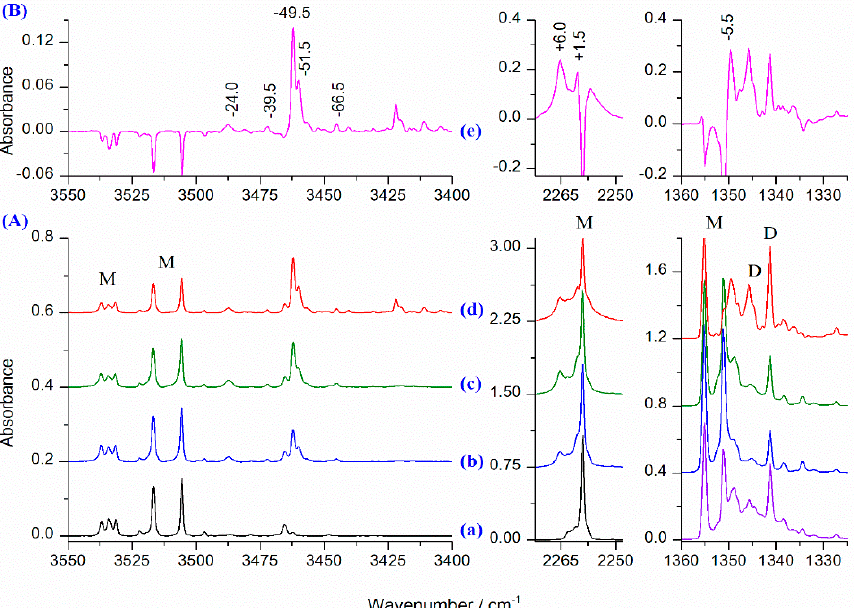
Figure 3. ( A ) The ν NH, ν as NCO and ν as SO 2 regions in the spectra of matrices: HNCO/Ar = 1/6000 or SO 2 /Ar = 1/1400 (after 5 min at 30 K/10 K) ( a ), HNCO/SO 2 /Ar = 1/2/5600 ( b ), HNCO/SO 2 /Ar = 1/4/5600 ( c ), and matrix ( c ) after 10 min at 30 K/10 K ( d ). ( B ) The difference spectrum ( e ) obtained by subtracting the spectrum ( a ) from the spectrum ( d ) (pink trace). The letters M and D denote HNCO and SO 2 monomers and dimer bands, respectively.